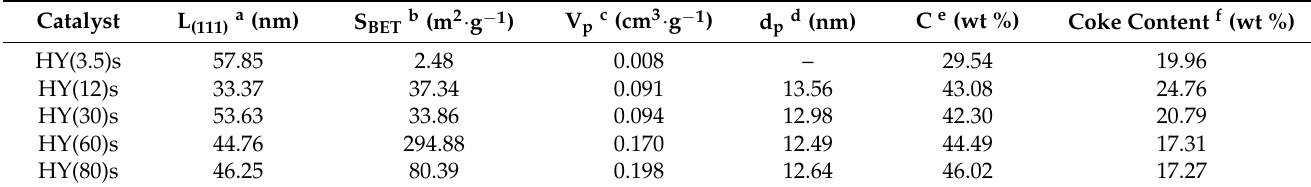
Table 4. Crystal size, textural properties and carbon content of the spent zeolites. Catalyst